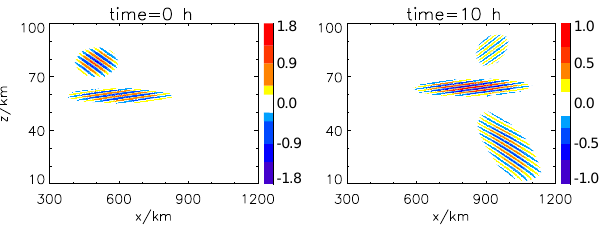
Fig. 7. Wave-wave nonlinear interaction in a nonisothermal and dis- sipative atmosphere by using square root density-weighted horizon- tal velocity disturbances.